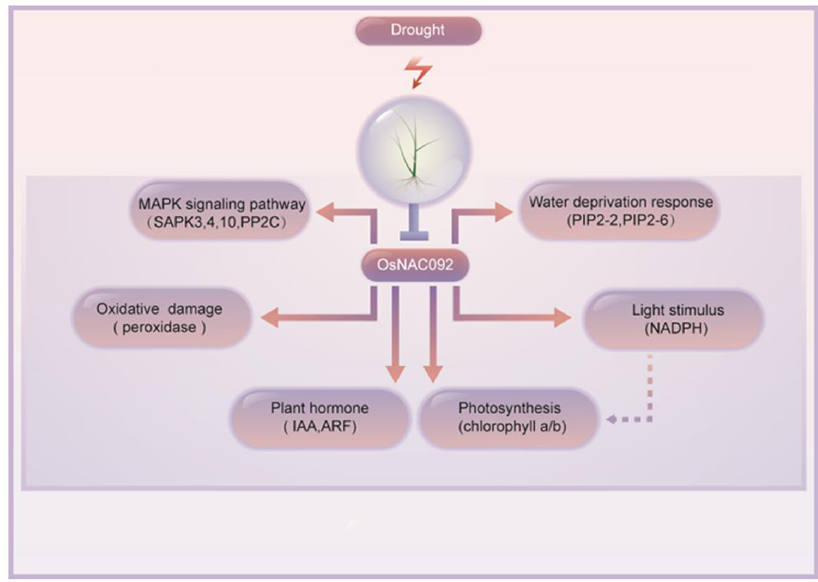
Figure 7. Predicted regulatory network of OsNAC092 under drought stress.